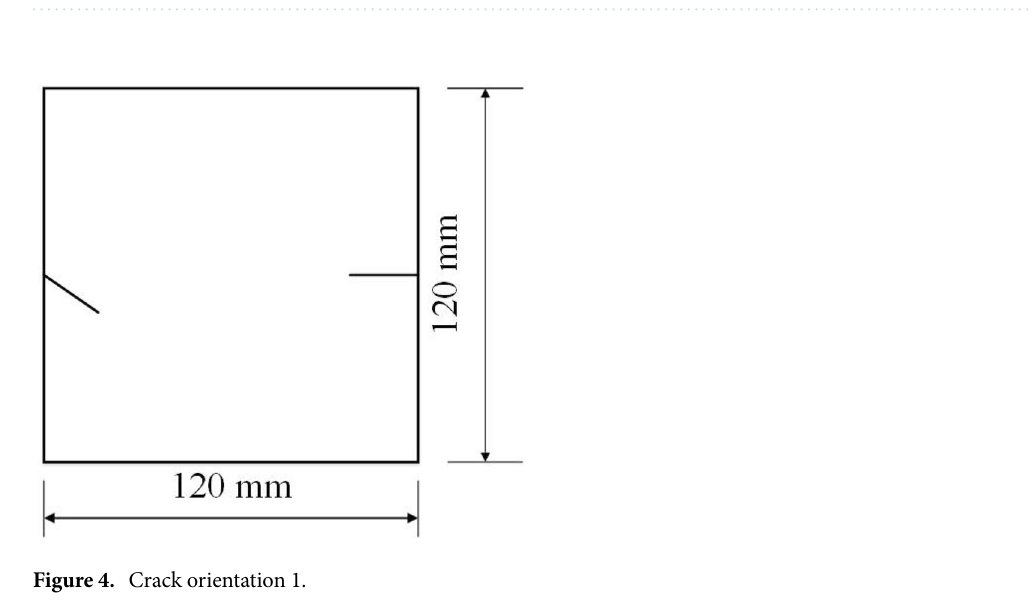
Figure 3. Photograph of the uniaxial press showing a specimen ready to be tested.